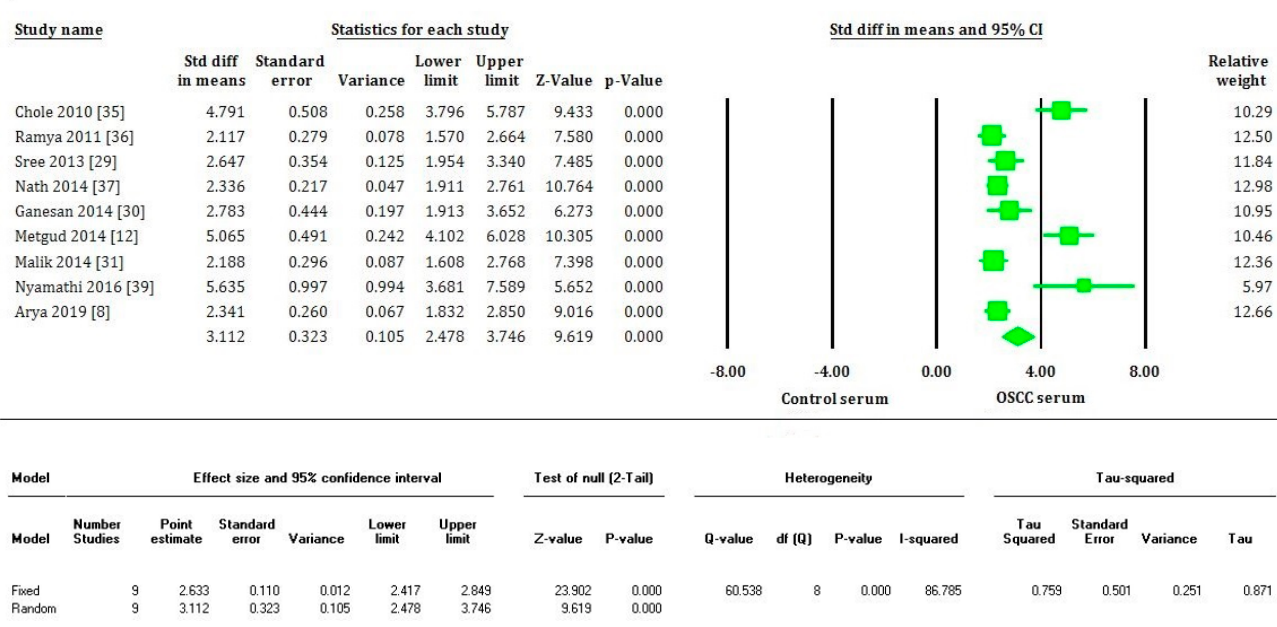
Figure 3. Forest plot shows mean difference estimates with 95% confidence intervals representing differences in serum levels of MDA between oral squamous cell carcinoma group and healthy controls.